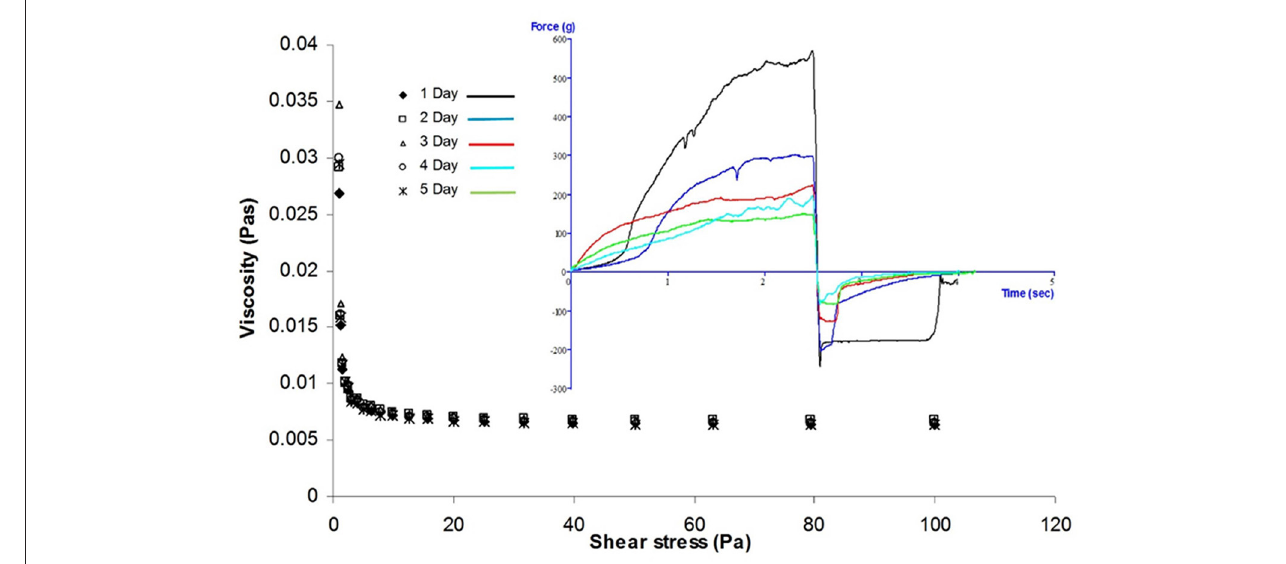
FIGURE 2 | Changes of texture and apparent viscosity during haria preparation.